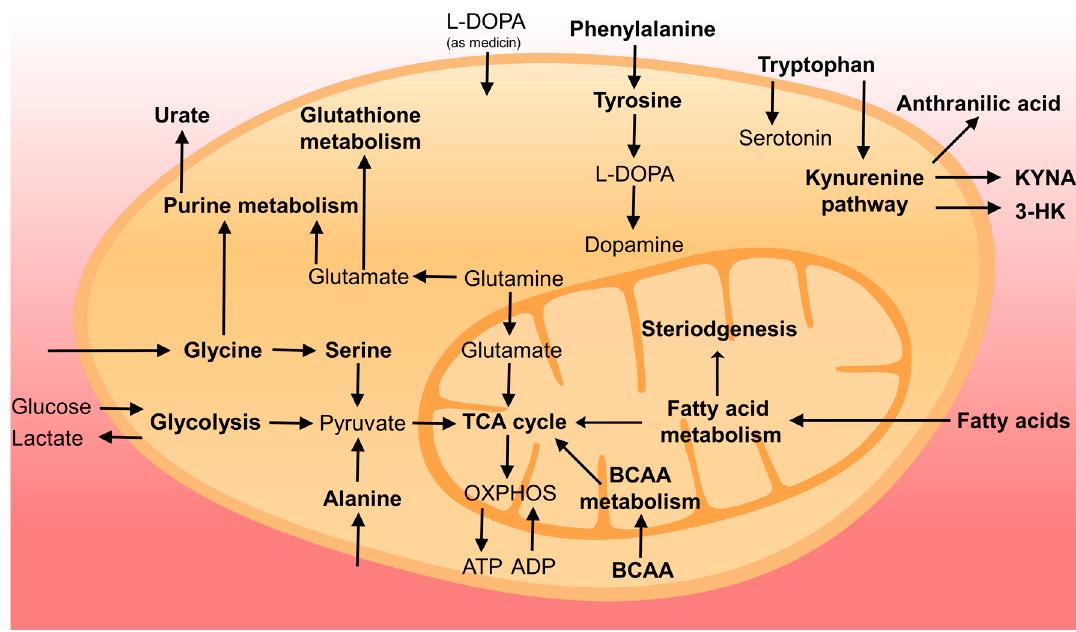
Figure 1. Overview of cellular metabolism changed in PD. Pathways or compounds specifically found in the literature are marked in bold. For simplicity, not all intermediates and reversible processes are shown.